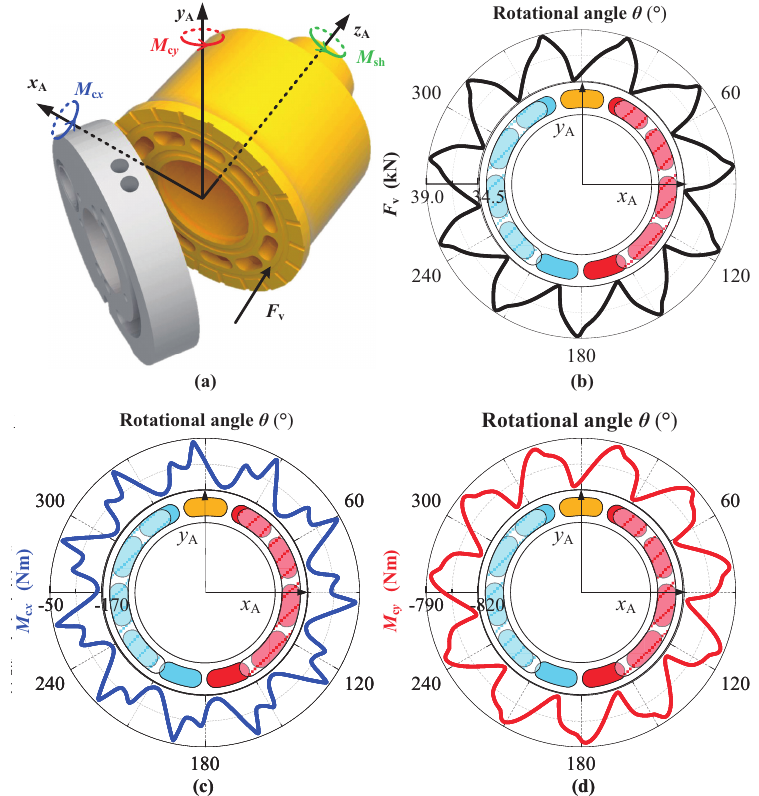
Figure 11. Overturning force and moments on the cylinder block. ( a ) Overturning force and moments. ( b ) Overturning force curve. ( c ) The moment curve in the x A axis direction. ( d ) The moment curve in the y A axis